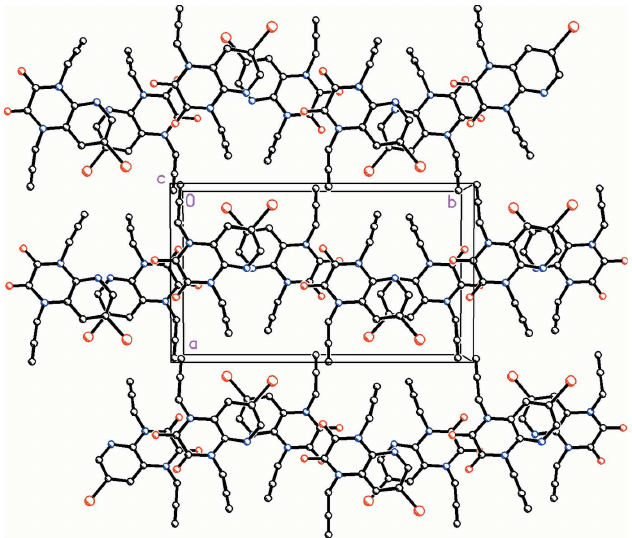
Figure 2 A partial view along the c axis of the crystal packing. All H atoms except H6 have been omitted for